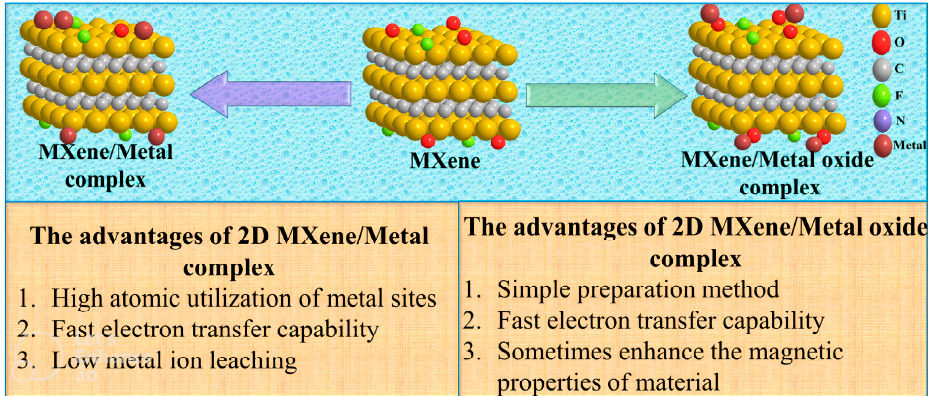
Figure 8. The bene fi ts of MXene/Metal and MXene/Metal oxide complex in the system of PS [165]. Figure 8. The benefits of MXene/Metal and MXene/Metal oxide complex in the system of PS [165]. MXene’s dimension is associated with its capability of activation. Because monolayer Two-dimensional MXene might serve as a connection platform for metal oxides. It MXene contains more exposed active sites, it has a superior PS activation capability than bulk MXene. Unlike multilayer 2D MXene bulk, monolayer 2D MXene also possesses a